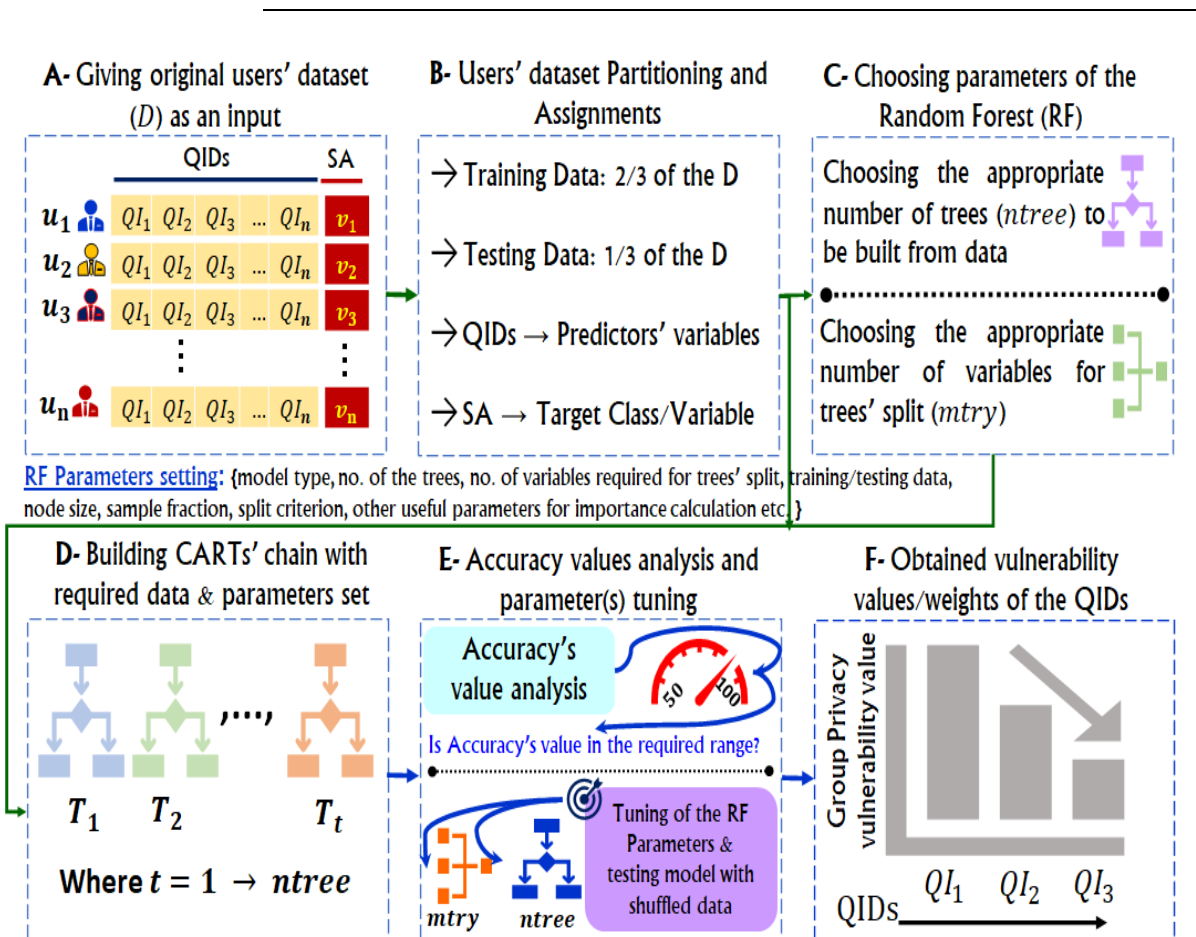
Figure 13. Computing the vulnerability of group privacy based on attribute values using